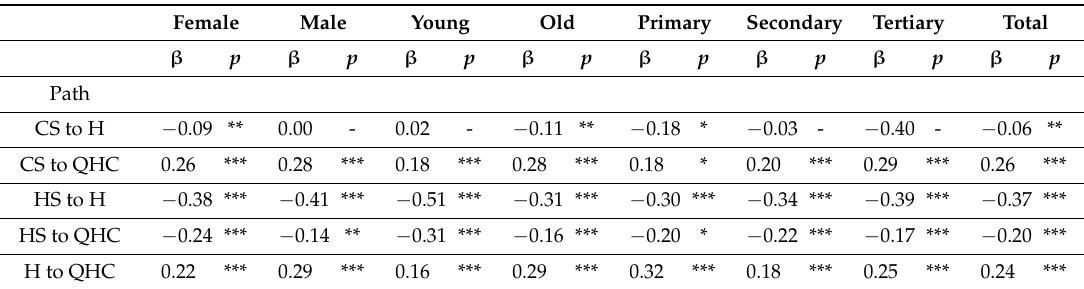
Table 4. Standardized regression weights ( β ) with p -values ( α = 0.05) for the components of the subgroup